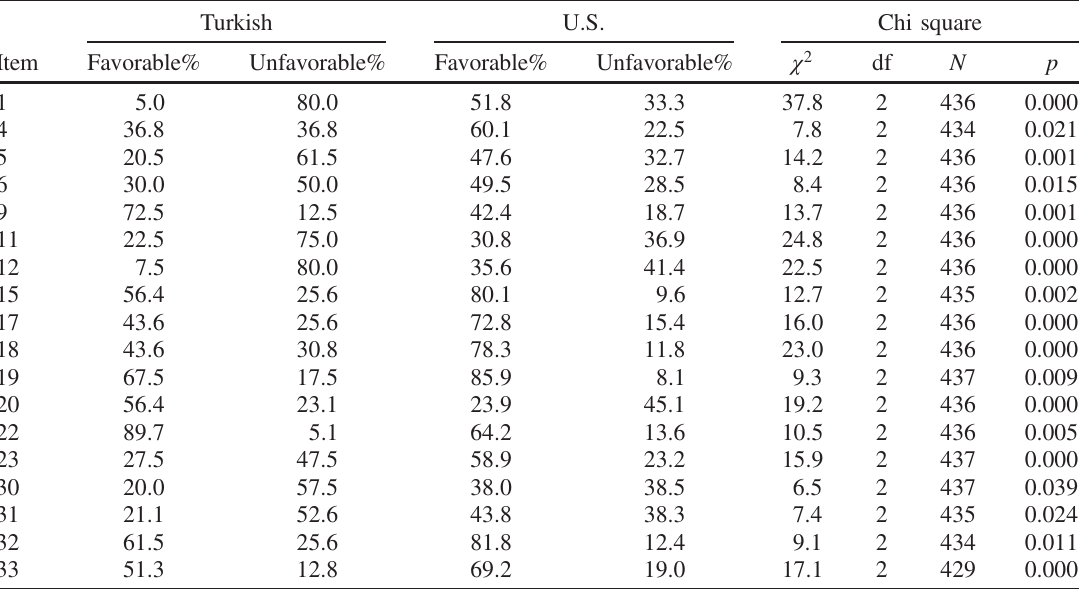
TABLE V. Percentages of Turkish and U.S. University (algebra-based courses) students ’ favorable and unfavorable attitudes and approaches to problem solving and corresponding chi-square statistics for items on which there is statistically significant difference. Note that the total number of students N is different between questions due to a few blank responses for some